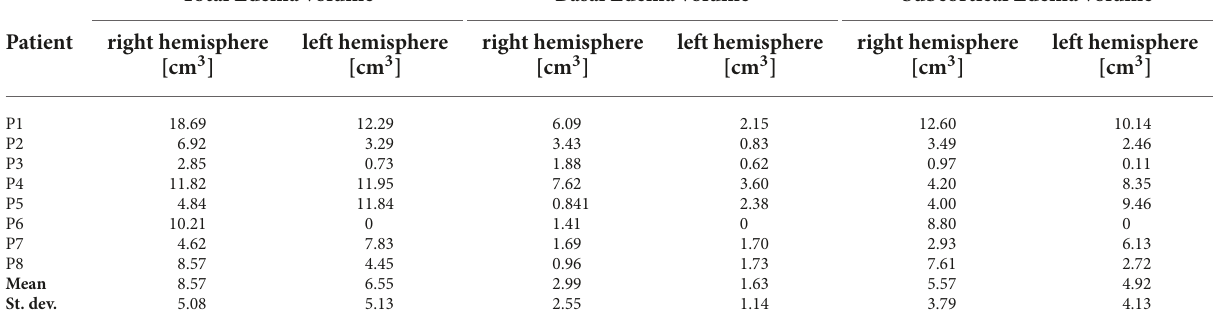
TABLE 3 Local field potentials left and right comparison. Frequency band Frequency range Mean Band Power [dB/H Z ] Wilcoxon probability Mean Left St.Dev.